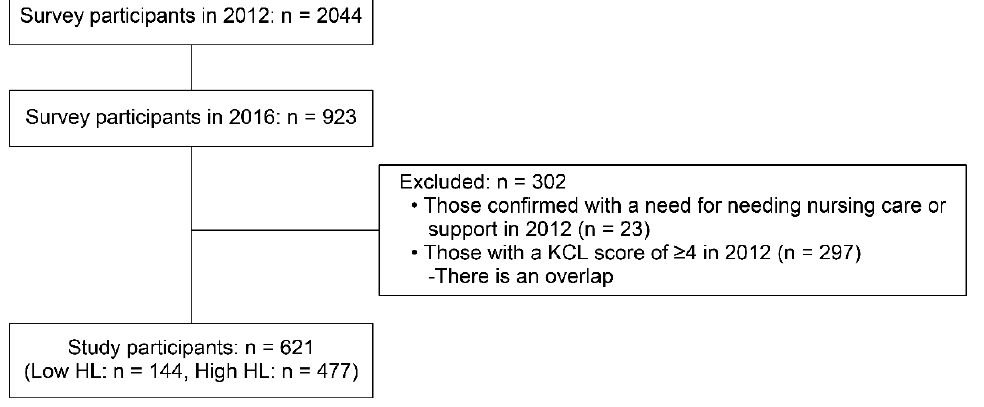
Figure 1. Data flow.